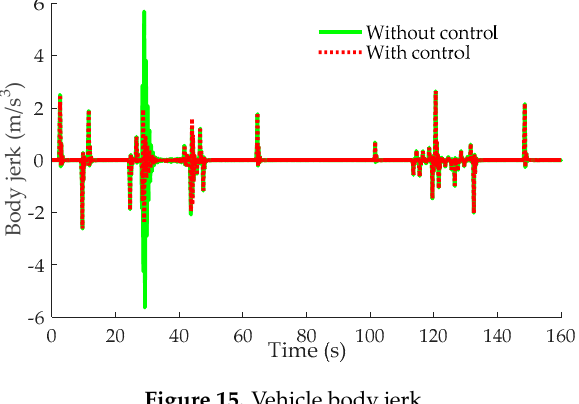
Figure 15. Vehicle body jerk.